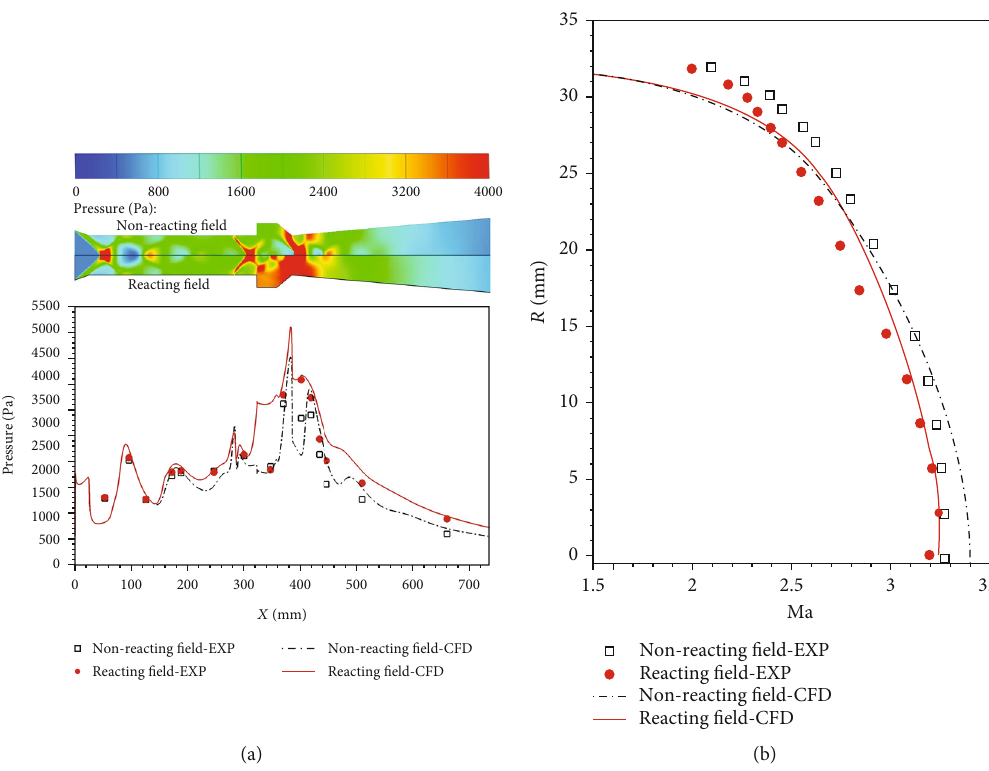
Figure 3: (a) Wall pressure and (b) exit Mach number comparison between numerical and experimental results [23] for the nonreacting and reacting fl ow fi elds; the pressure contour is also displayed to show fl ow